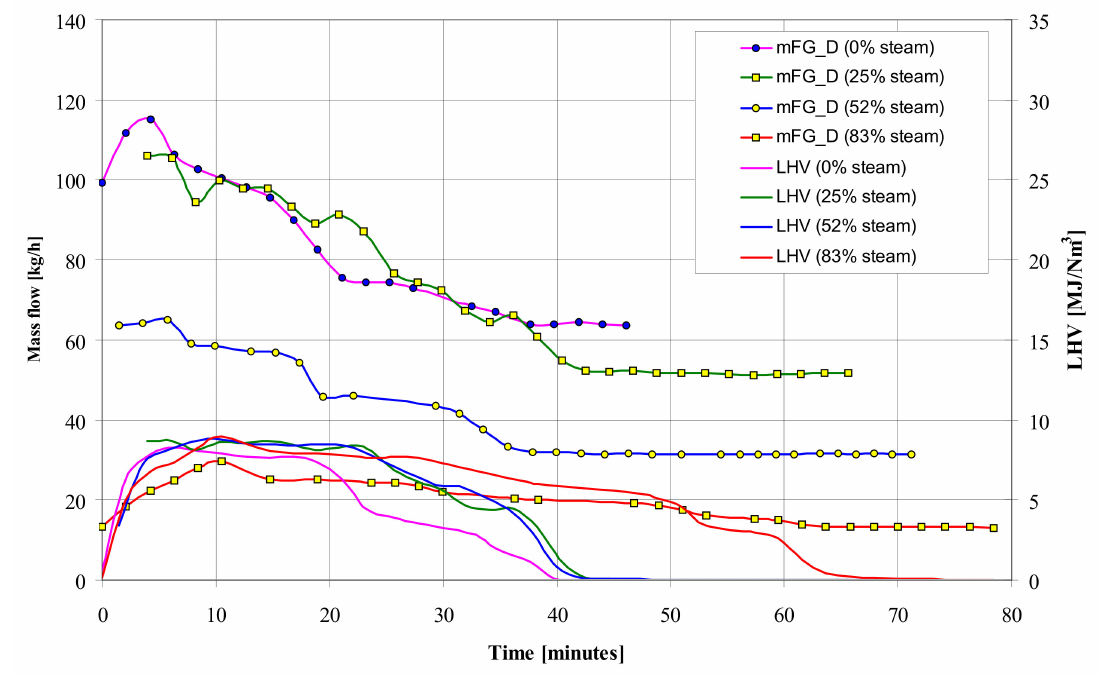
Figure 6. The amount of the produced gas fuel and its LHV for various gasification processes of 20 kg of 12 mm wood pellets.